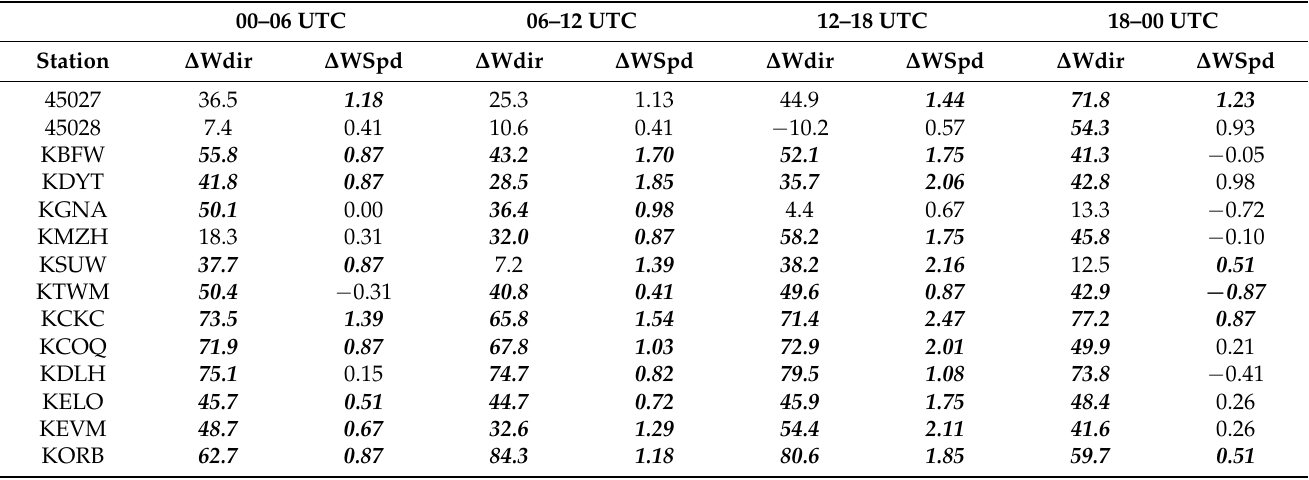
Table 7. As in Table 5 except for average wind direction (Wdir, degrees) and speed (WSpd, m s − 1 ) changes through the day. Values in bold/italics are significant at the 1% level, according to a Wilcoxon signed-rank